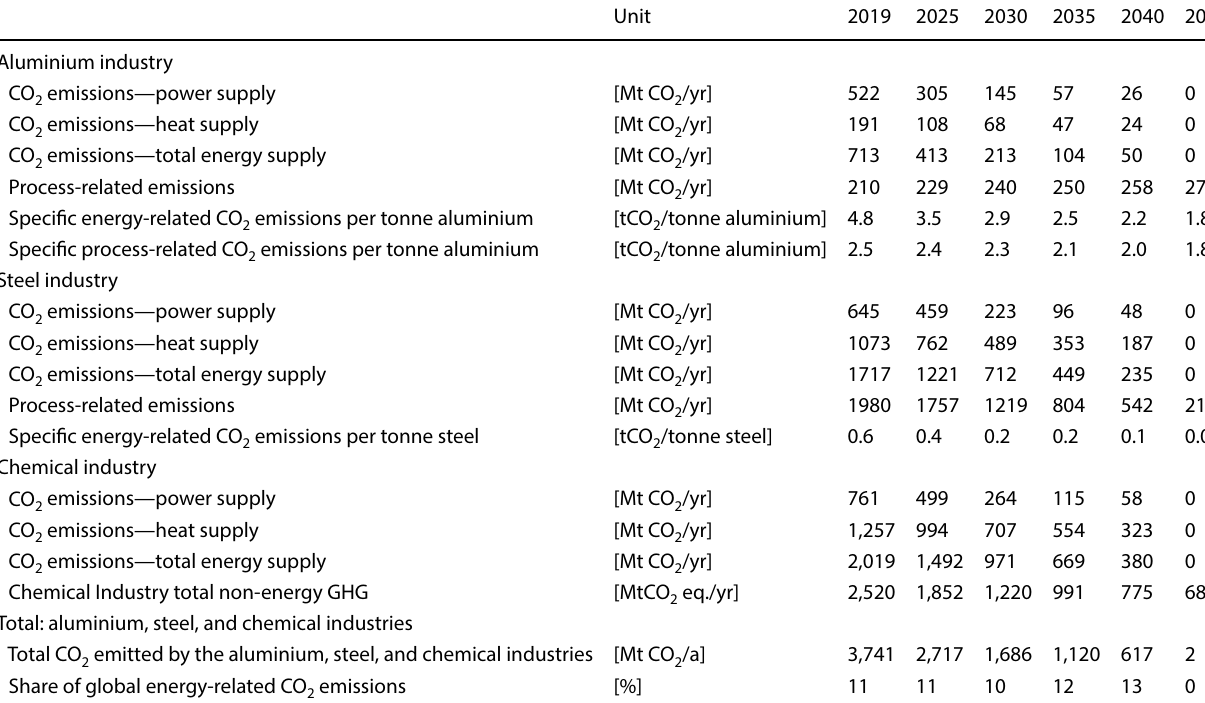
emissions—aluminium, steel, and chemical industries 2